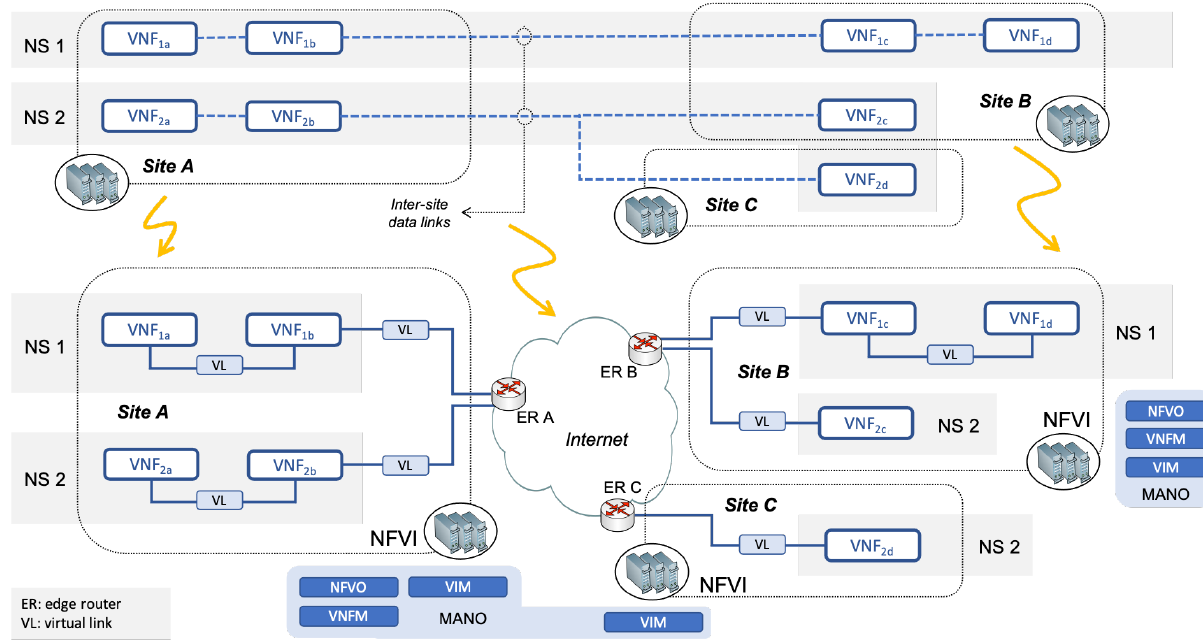
Figure 1. Reference Scenario for Inter-Site